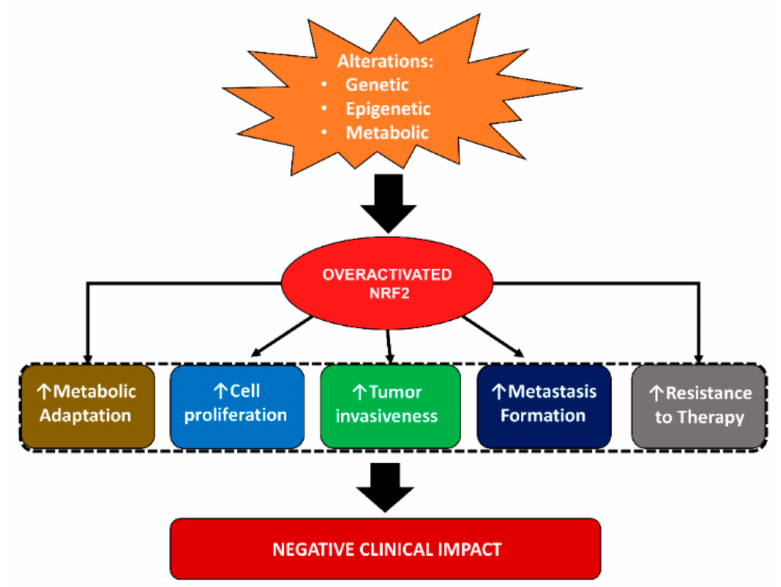
Figure 1. Roles of nuclear factor erythroid 2-related factor 2 (NRF2) in breast